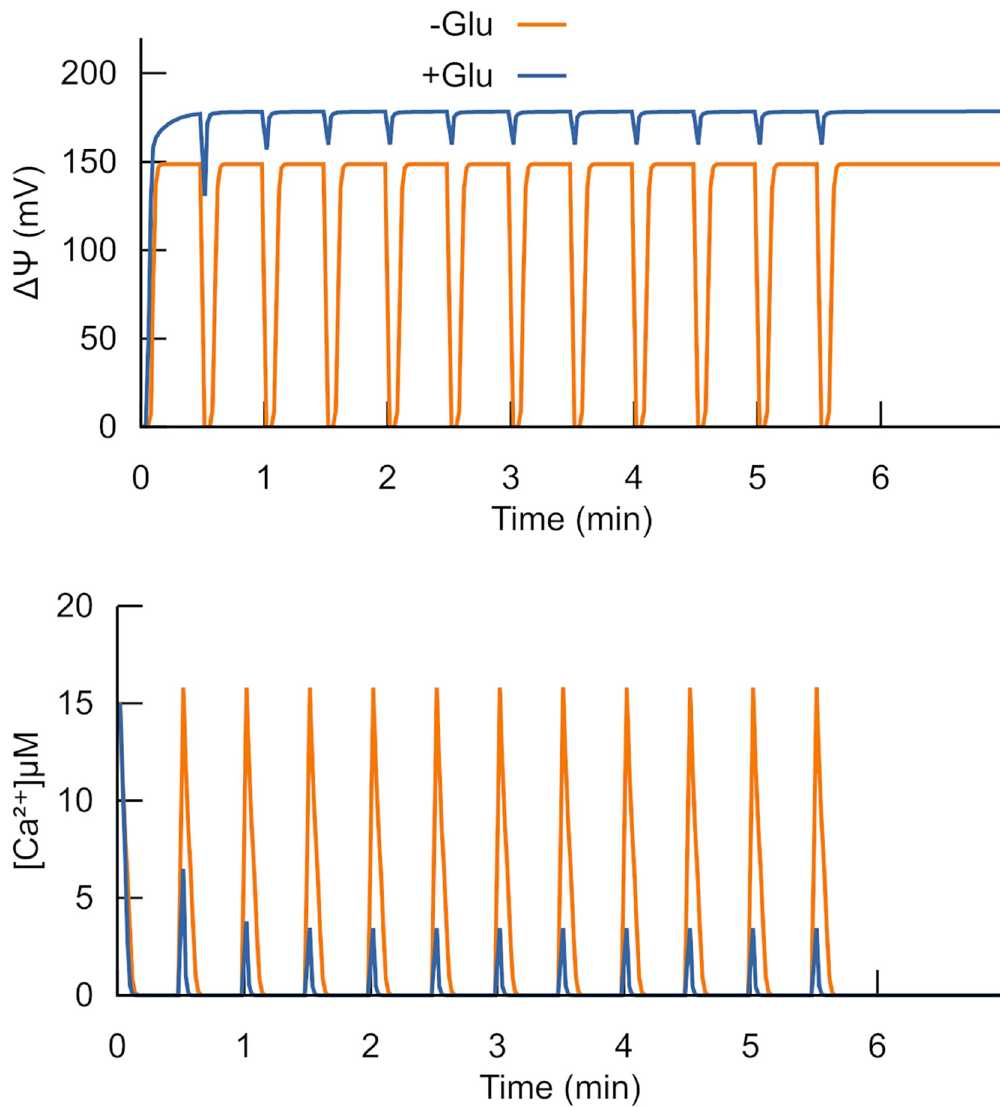
Fig 6. Glutamate—activated Ca 2+ uptake by mitochondria. The calculated dynamics of transmembrane potential (A) and Ca 2+ (B) in response to multiple additions of 20 nmol Ca 2+ . The uptake of positive Ca 2+ ions discharges the membrane. After the uptake, Δ ψ recovers. The model accounts for the uptake as JCa = P � Δ ψ � ([Ca 2+ ]o-[Ca 2+ ]i) � exp(zF Δ ψ /RT) /(1-exp((zF Δ ψ / RT)), here JCa is the uptake flux of Ca 2+ , P = 0.005 s -1 × mV -1 is permeability coefficient, Δ ψ is the transmembrane potential, z = 2 is the ion charge, R is the ideal gas constant, T is the temperature in kelvins, F is Faraday’s constant. RT/F is ~25.693 mV. d( Δ ψ )/dt = F/C � 2 � JCa describes the JCa dependent change of Δ ψ . C is the electric capacity of the membrane, F/C = 500 mV � nmol -1 � mg protein. The simulations correspond to the direct record of Ca 2+ uptake reported in Fig 4 of [29].